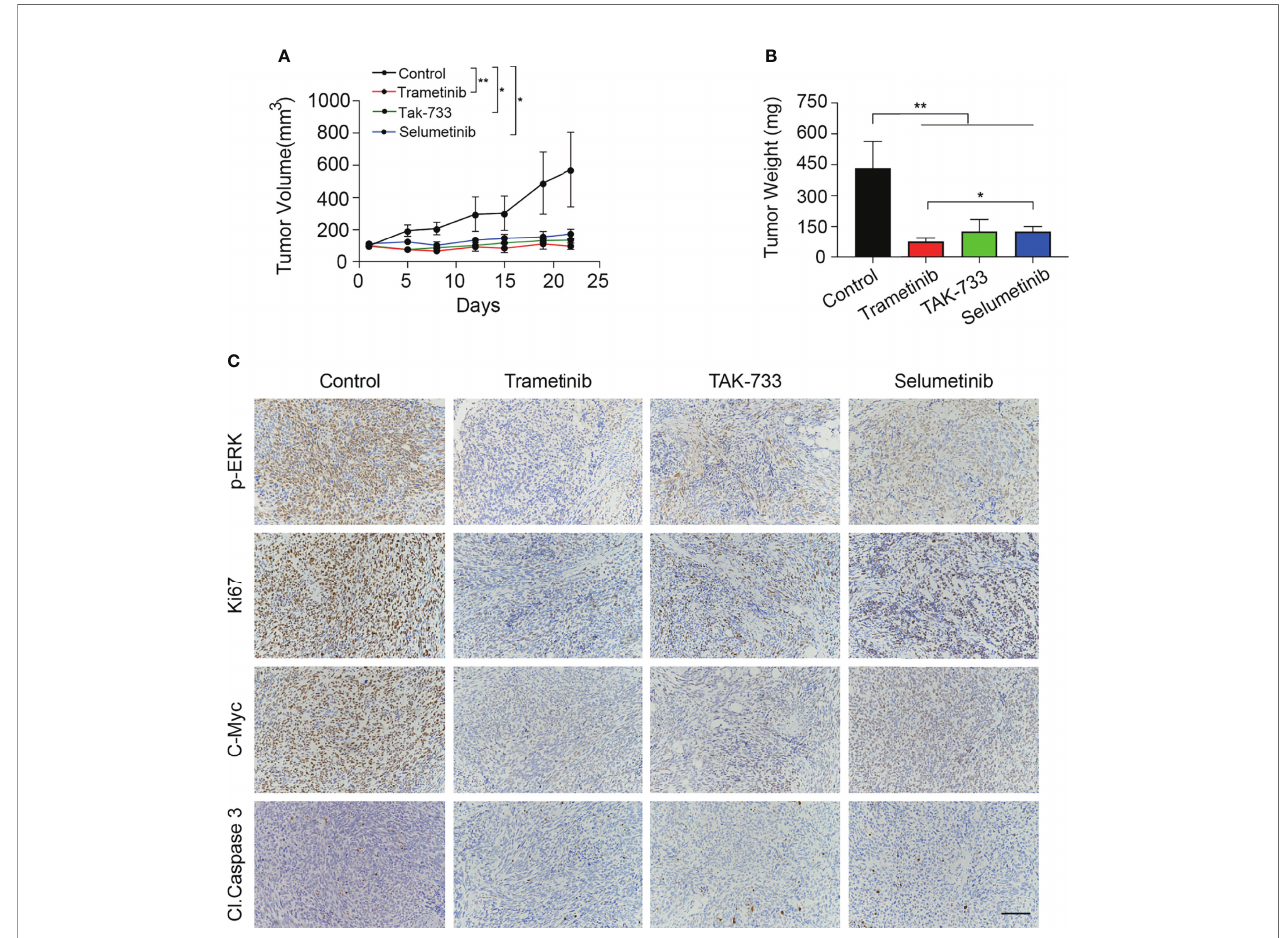
FIGURE 5 | MEK inhibitors signi fi cantly inhibited the growth of MPNST xenograft without inducing apoptosis. (A, B) Tumor growth curves (A) and tumor weight (B) of mice treated with control, trametinib, TAK-733 or selumetinib for three weeks. Each point or column represents Mean ± SEM (n = 4). * Represents p < 0.05, and ** represents p < 0.01 compared with control group (Student ’ s t-test). (C) Representative images of p-ERK, Ki67, C-Myc, and Cl. Caspase3 immunohistochemical staining from the extracted tumor tissues in the four groups (scale bar = 100 m